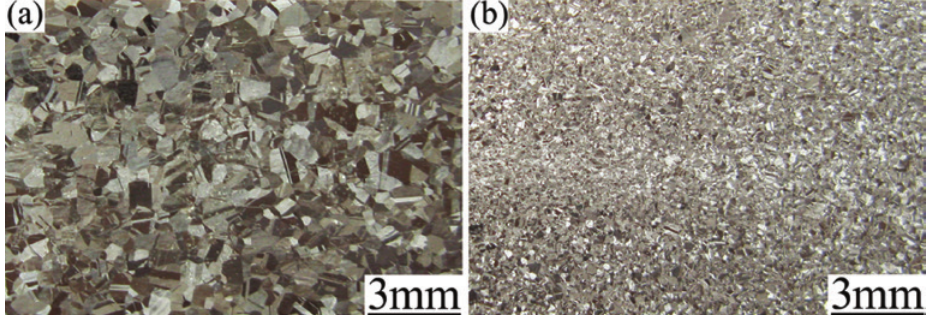
Fig. 3: Microstructure of tested alloys in the hot-forged condition: (a) alloy 1, (b) alloy